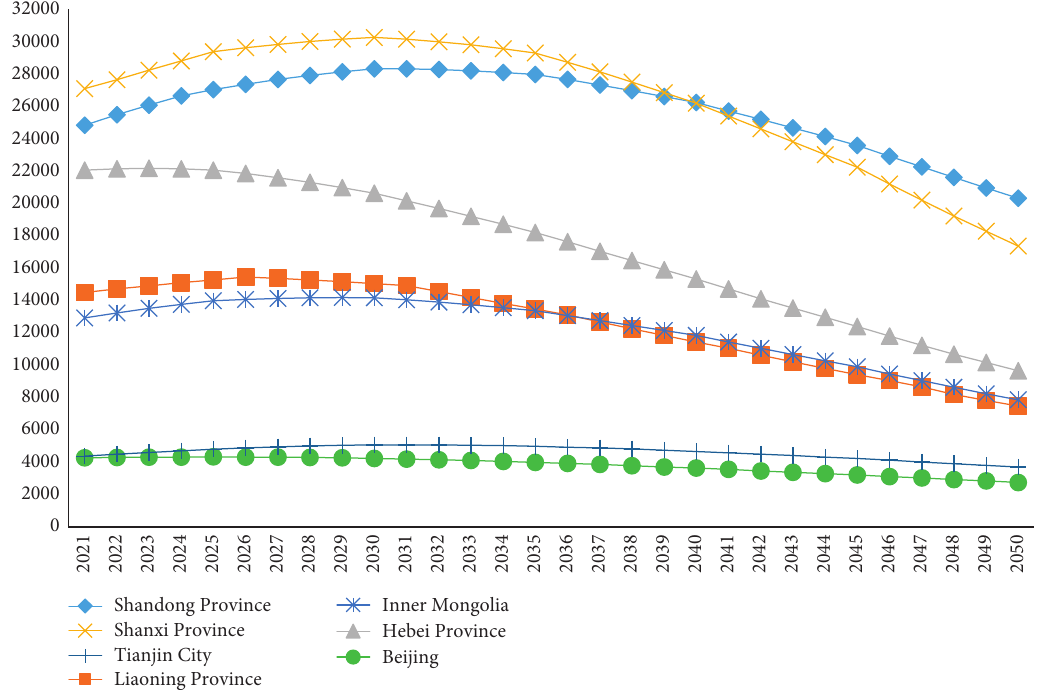
Figure 5: Carbon emissions of each province and city under the 2010–2020 scenario (unit: 10,000